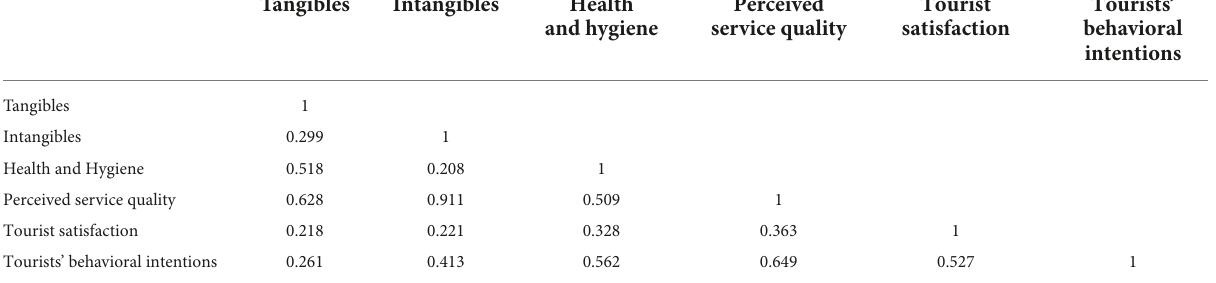
TABLE 8 Structural parameter